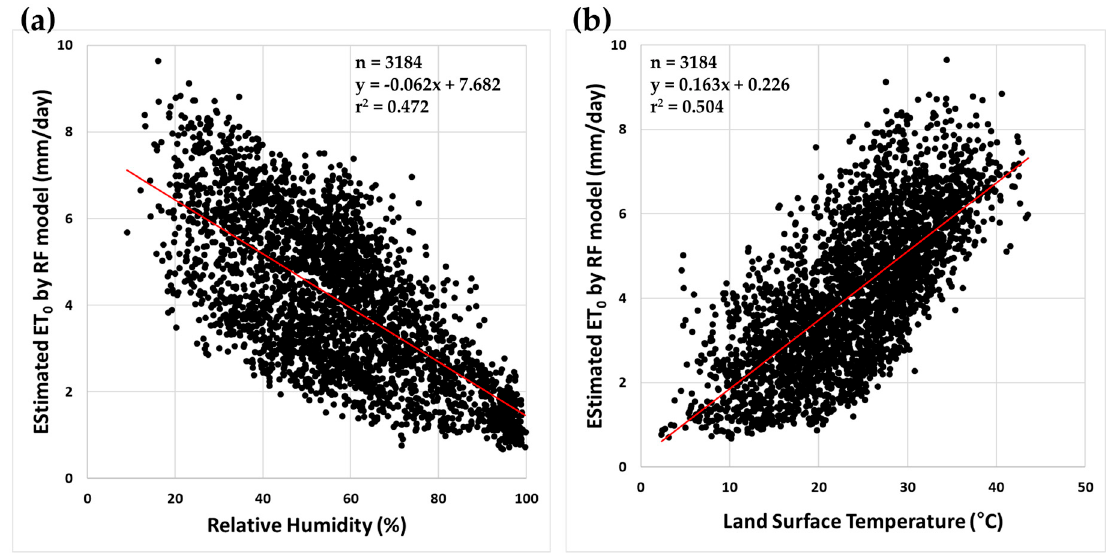
Figure 6. Relationships of the relative humidity vs. ET 0 ( a ) and the land surface temperature vs. ET 0 ( b ).